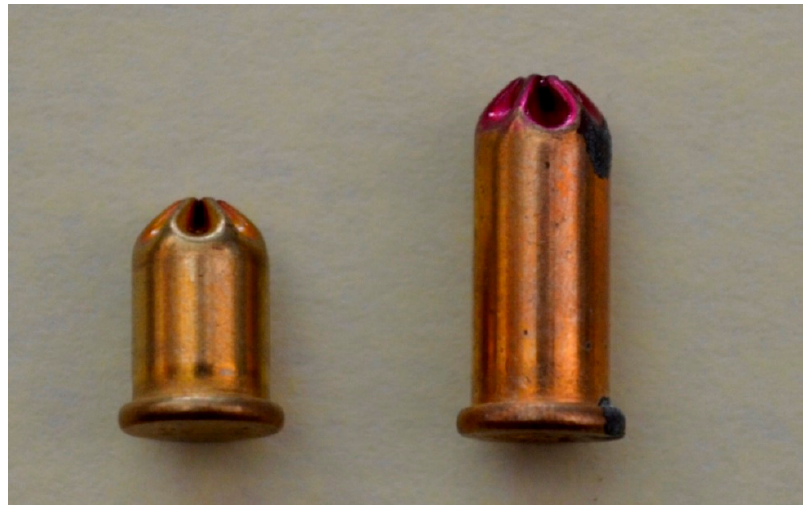
Figure 3. Temple Cox (manufacturer) 0.22 ″ blank cartridges: 1.00 grain cartridge on left; 2.00 grain cartridge on right.